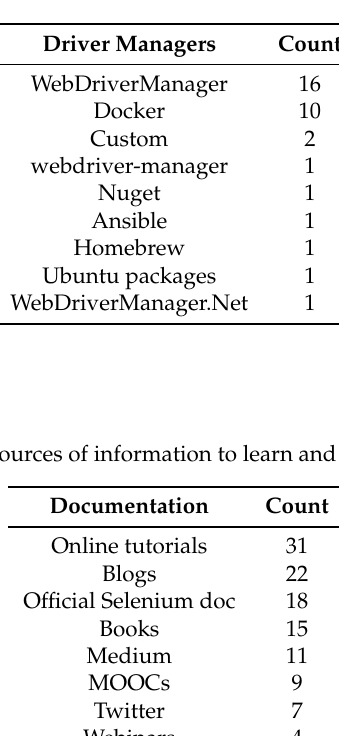
Table A17. 5.d. How do you manage the driver binaries (e.g., chromedriver , geckodriver ) required by Selenium WebDriver?